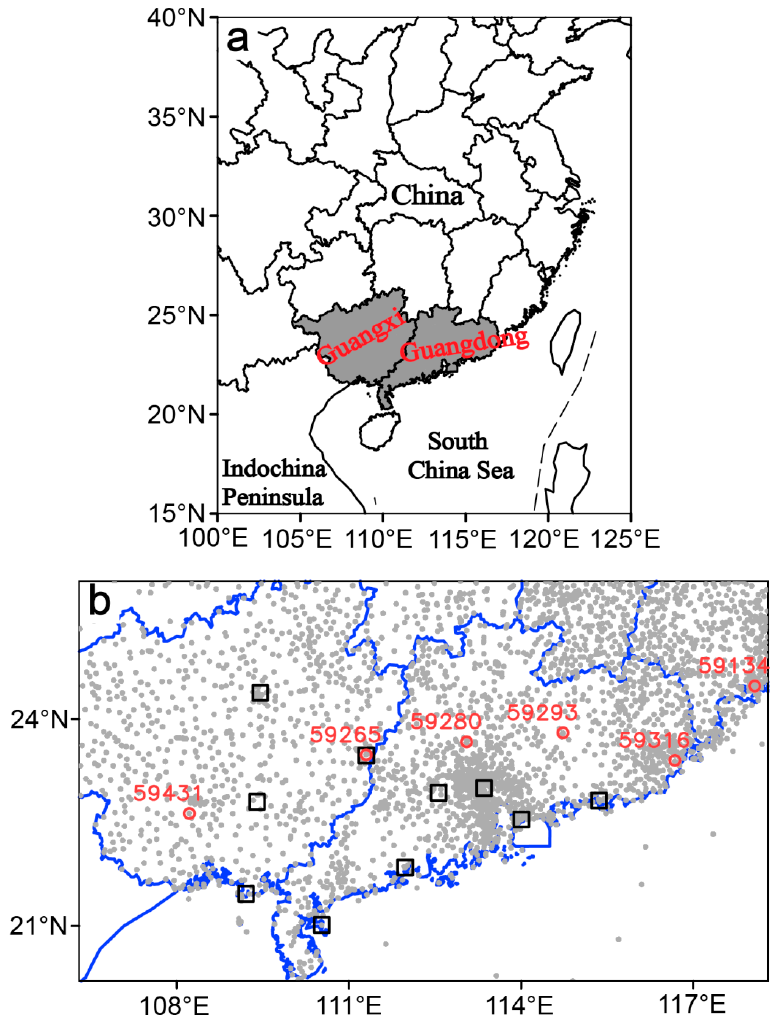
Figure 1. ( a ) Map of the locations of the provinces of Guangxi and Guangdong (the shaded areas) in South China. ( b ) Distributions of surface (dots), radiosonde (circles) and radar (rectangles) stations in the provinces of Guangxi and Guangdong. The numbers “59431”, “59265”, “59280”, “59293”, “59316” and “59134” denote radiosonde station IDs. Table 1. The occurrence times of the cases presenting sudden turning motion of mesoscale convective systems (MCSs) from eastward/northeastward to southeastward over South China during the April–June (pre-flood rainy season) periods of 2011-2017. Case IDs Main Periods of Sudden Turning of